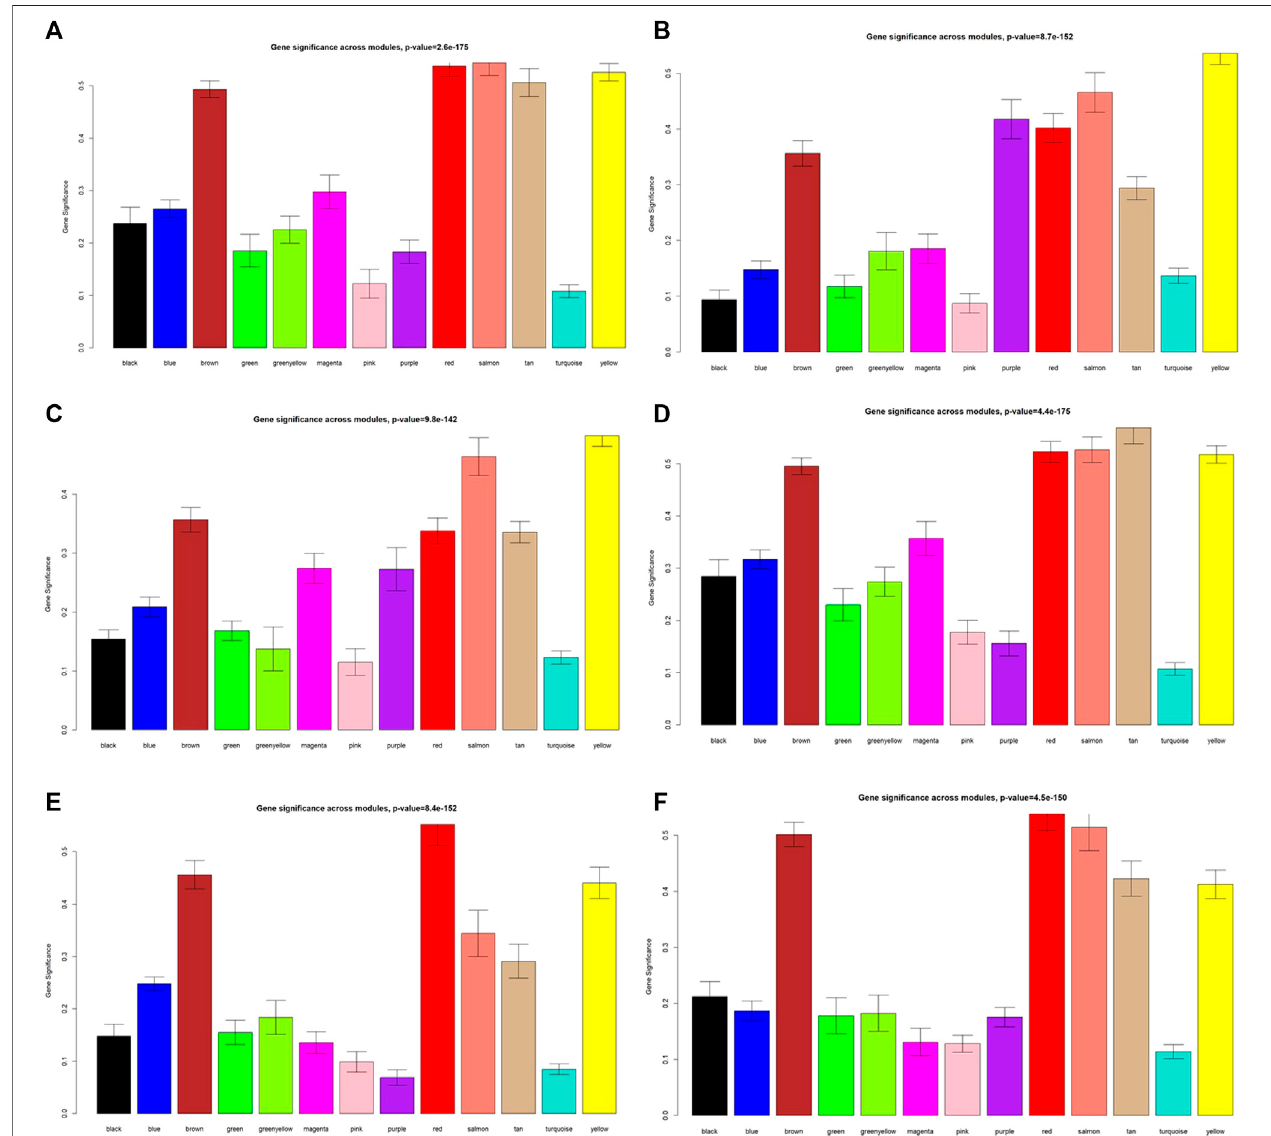
FIGURE 5 | Module signi fi cance values of co-expression modules related to different phenotypes. (A) GD; (B) FT3; (C) FT4; (D) , TSH; (E) TPOAb; (F) TRAb. Each color indicated one coexpression module.